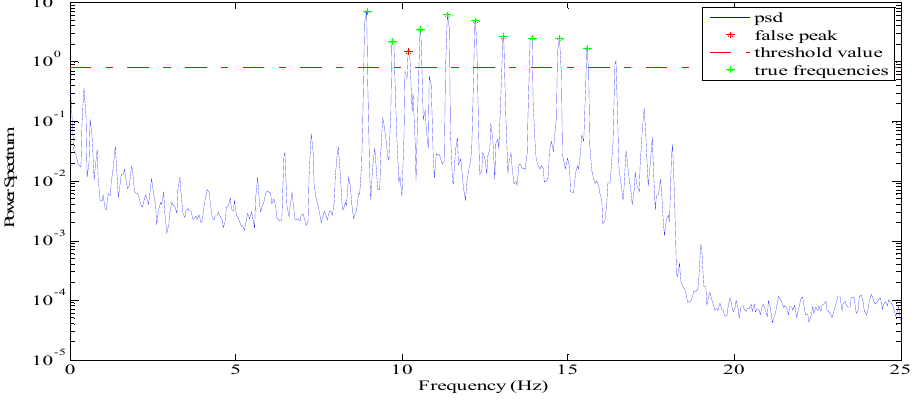
Figure 6. Frequency with false peaks.